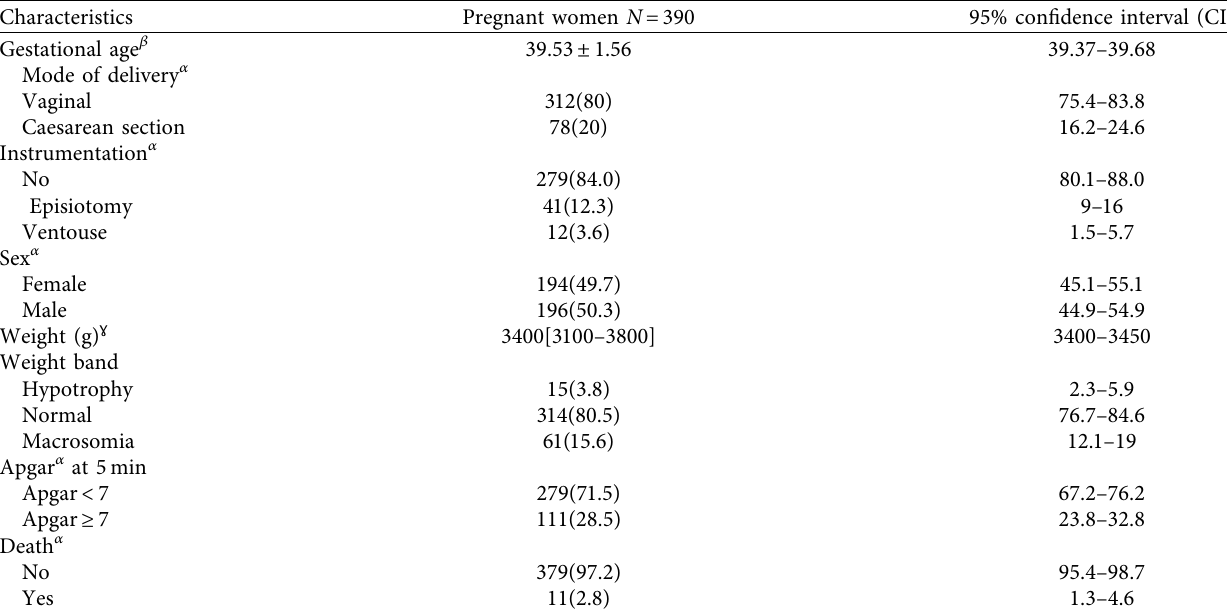
Table 3: Birth history and neonatal